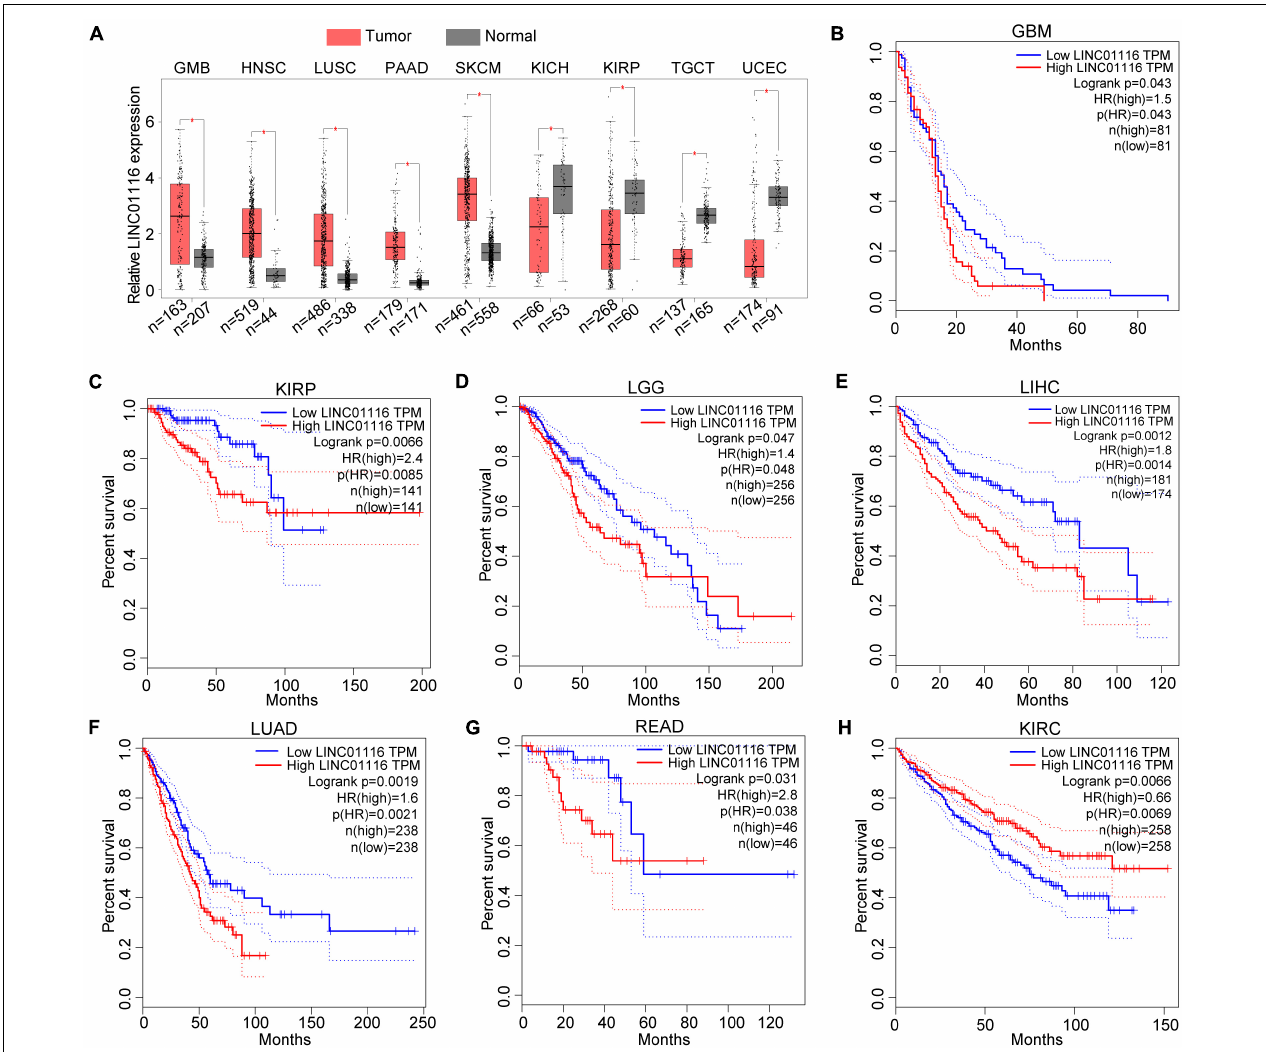
FIGURE 1 | Expression and prognostic roles of LINC01116 in different cancer types. (A) Dysregulated expression of LINC01116 in GMB, HNSC, LUSC, PAAD, SKCM, KICH, KIRP, TGCT, and UCEC. (B–G) Patients with highly expressed LINC01116 had poor overall survival (OS) rate compared those with lowly expressed LINC01116 in GBM, KIRP, LGG, LIHC, LUAD, and READ. (H) Patients with decreased LINC01116 expression had poor overall survival (OS) rate compared those with increased LINC01116 expressed in KIRC.